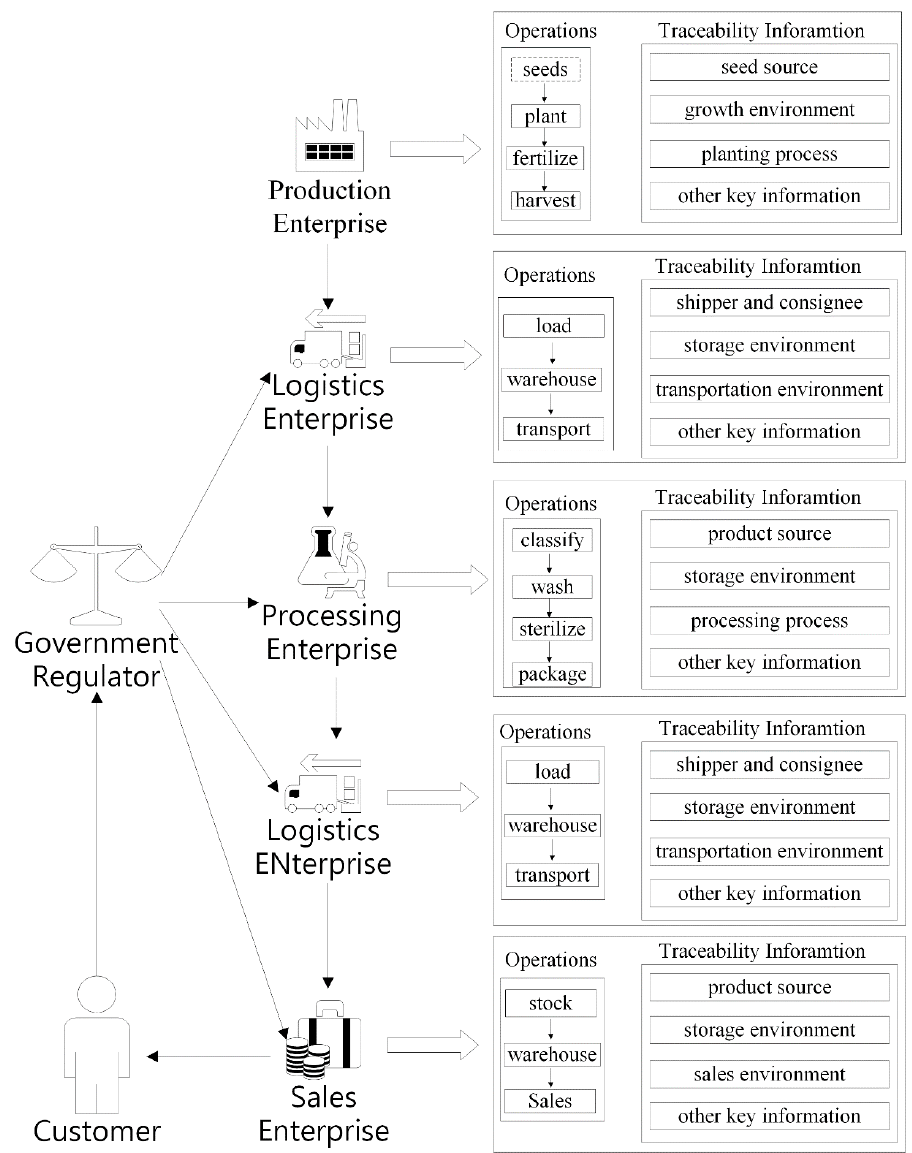
Figure 3. The agricultural supply chain process.